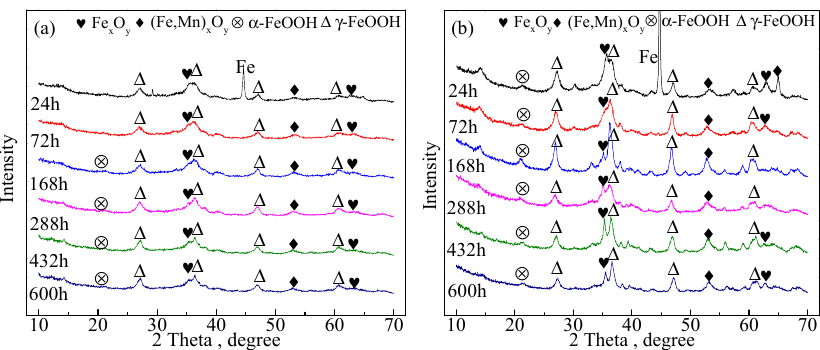
Figure 2. XRD patterns of the tested coupons after different corrosion times exposed to a 3.5 wt % NaCl solution for different lengths of time at 25 °C: ( a ) medium-Mn steel; and ( b ) Q345 steel.